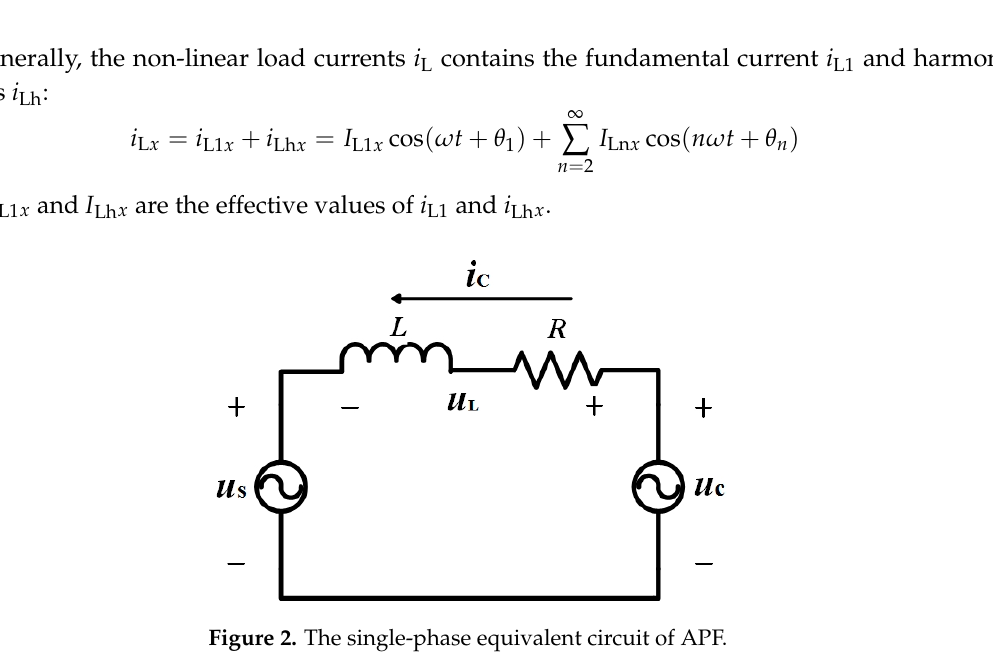
Figure 2. The single-phase equivalent circuit of APF.